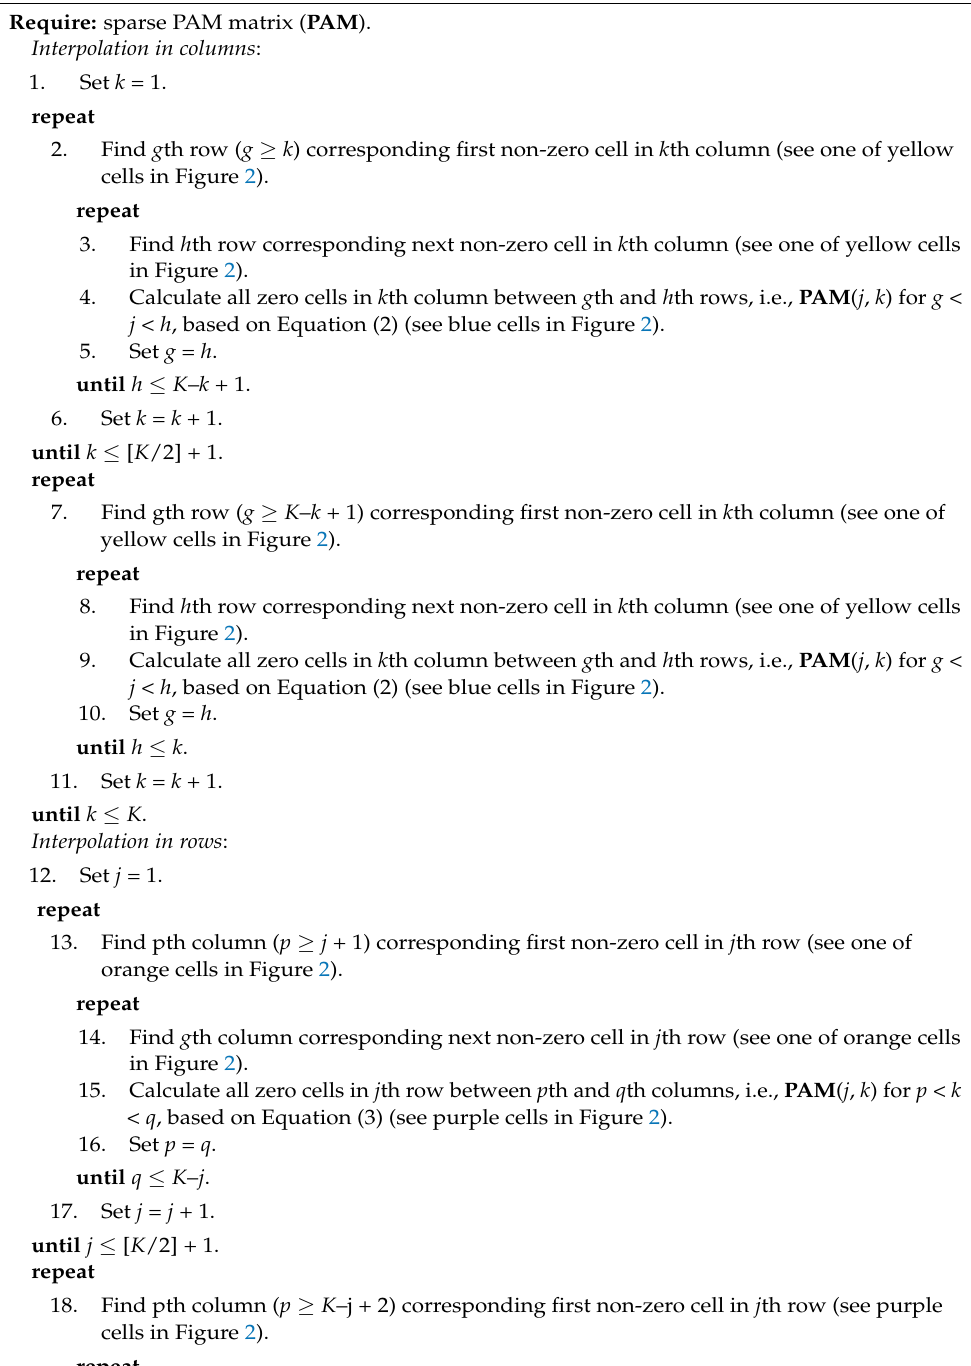
Algorithm 2 (Creating full PAM matrix based on